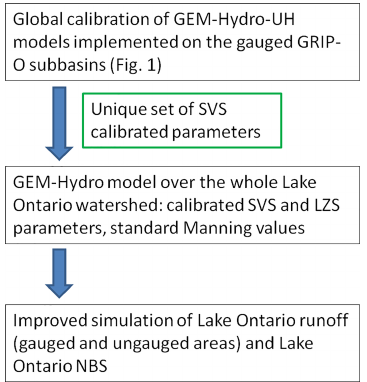
Figure 4. Diagram summarizing the methodology employed to sim- ulate Lake Ontario runoff with